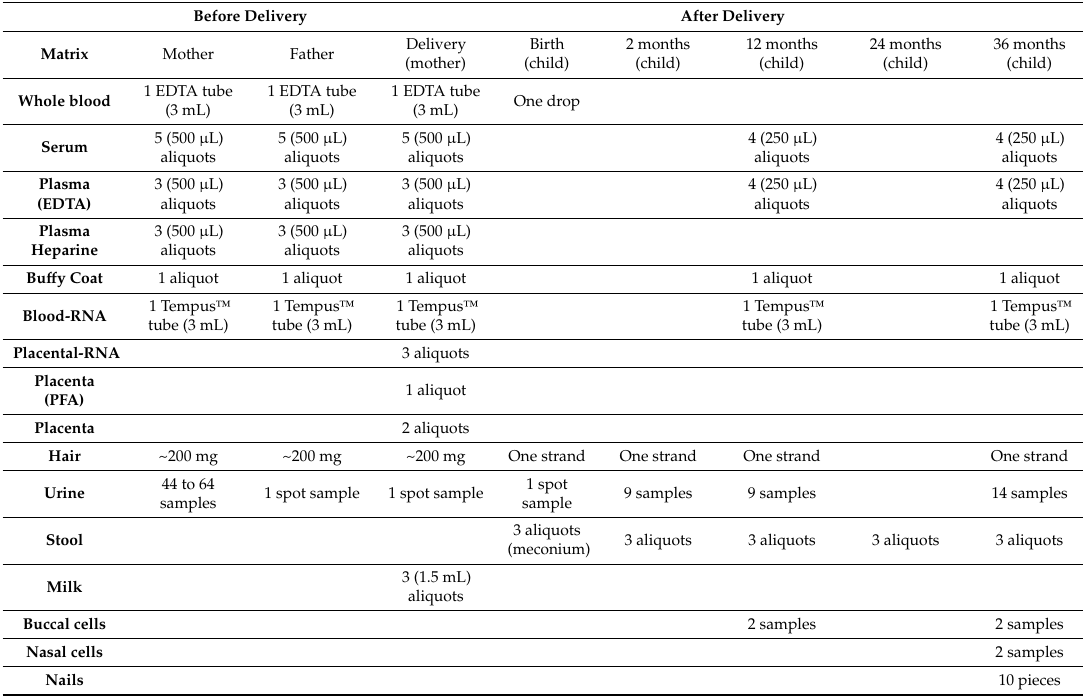
Table 3. Biological samples collected in SEPAGES